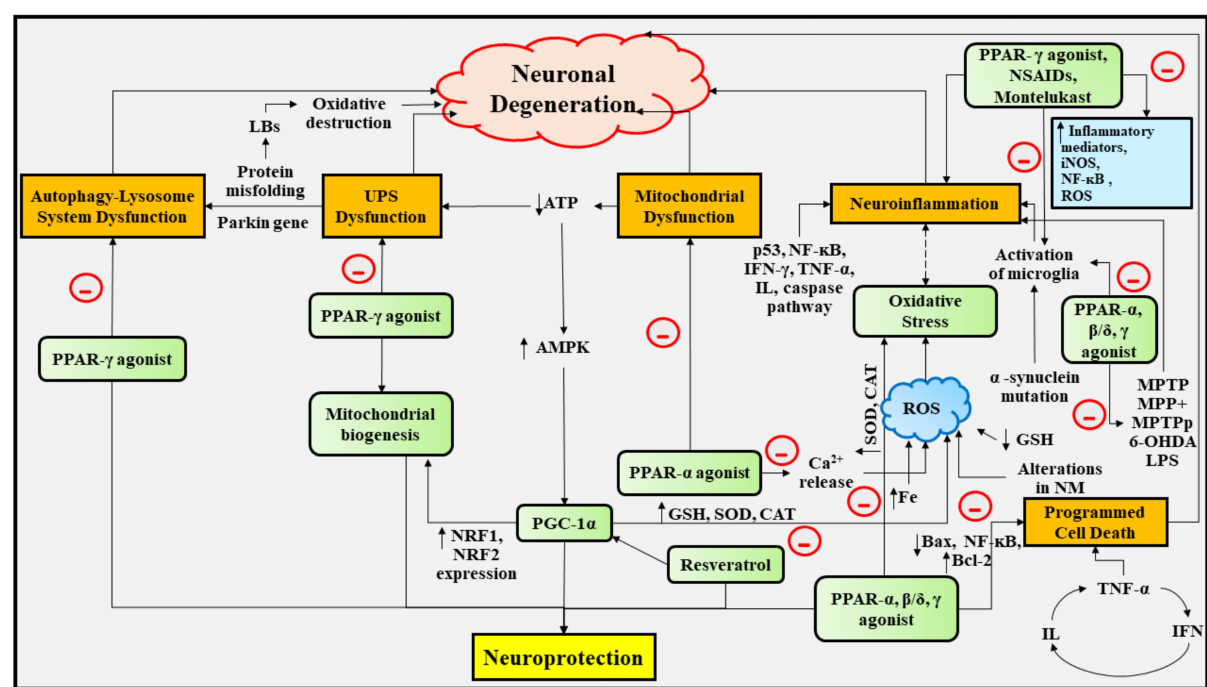
Figure 4. Pathways implicated in neuroprotection by means of PPARs in Parkinson’s disease. Genetic mutations as well as environmental factors play a pivotal role in the evolution of PD. Oxidative stress, UPS dysfunction, autophagy- lysosome system dysfunction, mitochondrial dysfunction, neuroinflammation, and programmed cell death contribute to the pathogenesis of PD. Each of these contributing factors may not be present simultaneously, and their association appears to participate in PD pathogenesis. Exposure to environmental toxins provokes oxidative stress, and activation of microglia. In addition, α -synuclein mutation also leads to the activation of microglia, and further provokes neuroinflammation. Activation of microglia in turn triggers the liberation of mediators of inflammation and ROS generation, which eventually prompt nerve cell degeneration via programmed cell death or necrosis. Analogously, apoptotic nerve cells liberate ROS and a variety of pernicious substances, which might aggravate the inflammatory processes precipitated via the activation of microglia. Ca 2+ release, increased Fe levels, decreased GSH, and alterations in NM promote ROS generation, which leads to oxidative stress. Decrease in ATP as a result of mitochondrial dysfunction results in UPS dysfunction, aberrant protein build-up, and oxidative destruction effectuated neuronal degeneration. Parkin gene mutations result in autophagy- lysosome system dysfunction and mitochondrial dysfunction, which consecutively promotes neuronal degeneration. PPAR agonists render neuronal protection through the suppression of autophagy-lysosome system dysfunction, UPS dysfunction, mitochondrial dysfunction, oxidative stress, neuroinflammation, and programmed cell death. PPAR agonists, by elevating the levels of SOD and CAT decrease the oxidative stress. These agonists suppress the toxin exposure triggered activation of microglia. Further, PPAR agonists, NSAIDs, and montelukast diminish the expression of iNOS, NF- κ B, ROS, inflammatory mediators, microglia activation, and neuroinflammation. Analogously, they also decrease the programmed cell death via suppressing the phosphorylation of Bax and NF- κ B expression, and by prompting the expression of Bcl-2. Besides, a PPAR- γ -coactivator, namely PGC-1 α decreases oxidative stress by elevating the levels of GSH, SOD, and CAT, and provokes the NRF1 and NRF2 (downstream target genes) expression implicated in mitochondrial biogenesis, thereby rendering neuronal protection. Apart from this, an antioxidant, namely resveratrol, also exhibits neuroprotective action by activating PGC-1 α . Minus sign denotes suppressing/diminishing action, whereas arrow denotes promoting action. LBs, lewy bodies; Parkin , Parkin RBR E3 ubiquitin-protein ligase ; UPS, ubiquitin-proteasome system; NRF1, nuclear respiratory factor 1; NRF2, nuclear respiratory factor 2; ATP, Adenosine triphosphate; AMPK, AMP-activated protein kinase; PGC-1 α , PPAR-gamma co-activator-1 alpha; GSH, glutathione; SOD, superoxide dismutase; CAT, catalase; Ca 2+ , calcium; Fe, iron; NM, neuromelanin; ROS, reactive oxygen species; NF- κ B, nuclear factor kappa B; IFN γ , interferon gamma; TNF- α , tumor necrosis factor- α ; IL, interleukins; NSAIDs, non-steroidal anti-inflammatory drugs; iNOS, inducible nitric oxide synthase; MPTP, 1-methyl-4-phenyl-1,2,3,6-tetrahydropyridine; MPTPp, probenecid model of Parkinson’s disease; MPP+, 1-methyl-4- phenylpyridinium ion; 6-OHDA, 6-hydroxyDA; LPS, lipopolysaccharide; Bcl-2, B-cell lymphoma 2; IFN, interferons; PD, Parkinson’s disease; ↑ , increasing/activating/enhancing; ↓ ,